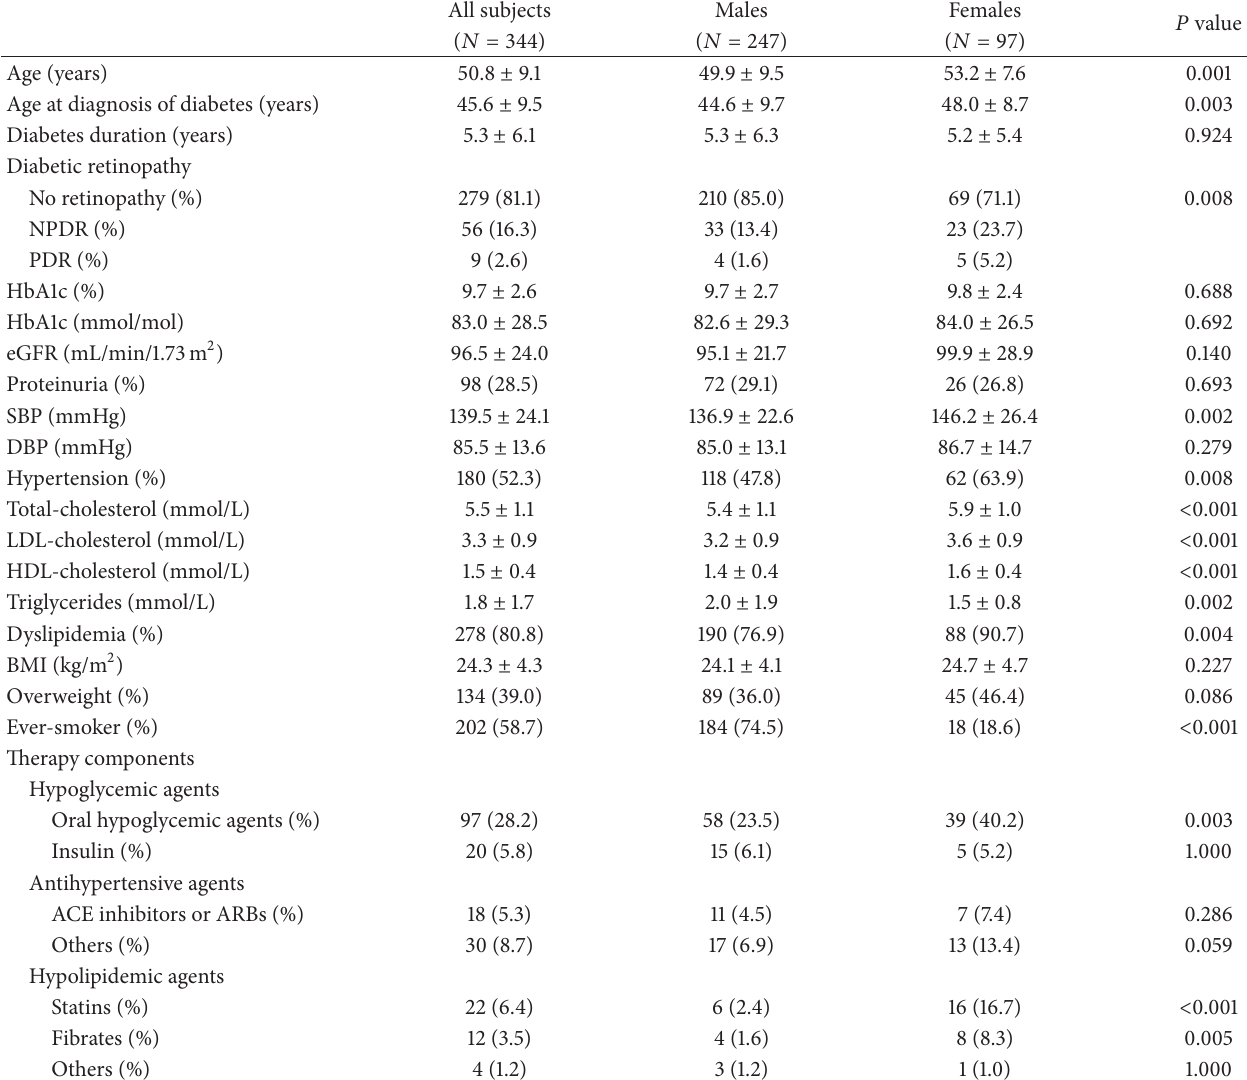
Table 1: The baseline characteristics of the overall study population and separated by